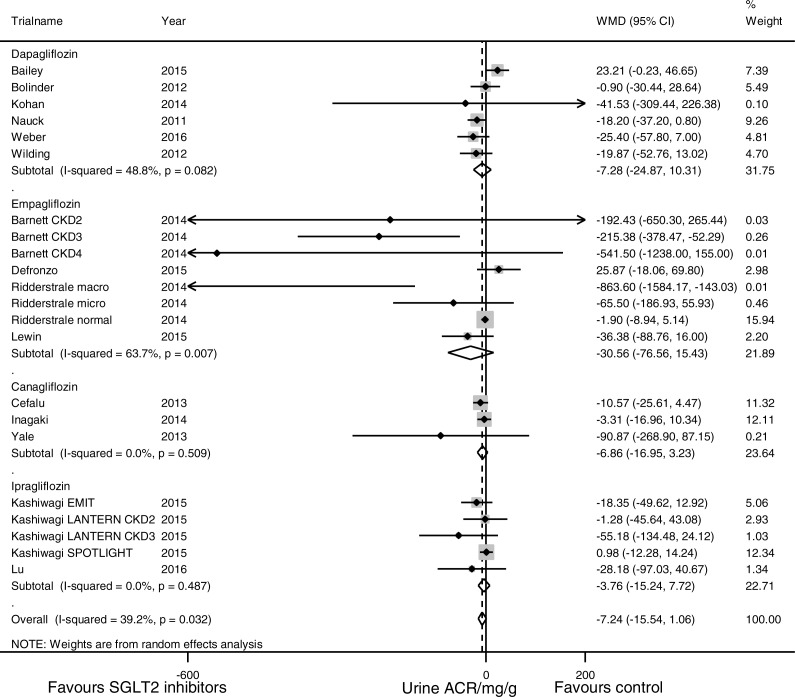
Effect of SGLT2 inhibition on urine albumin/creatinine ratio (ACR).The black dots represent mean differences of changes in urine ACR, calculated as ((end of trial urine ACR for SGLT2 inhibition–baseline urine ACR for SGLT2 inhibition)–(end of trial urine ACR for control—baseline urine ACR for control)). The gray squares represent weights calculated using the random-effects model. The horizontal lines represent 95% confidence intervals (CIs). The hollow diamonds represent pooled mean differences and their 95% CIs. Negative values indicate that the SGLT2 inhibition group had less albuminuria than control. Urine ACR in mg/g.